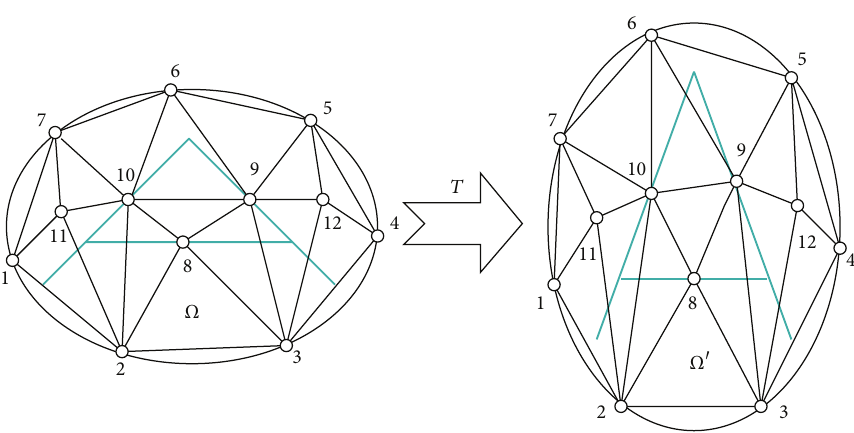
Figure 5: Finite element